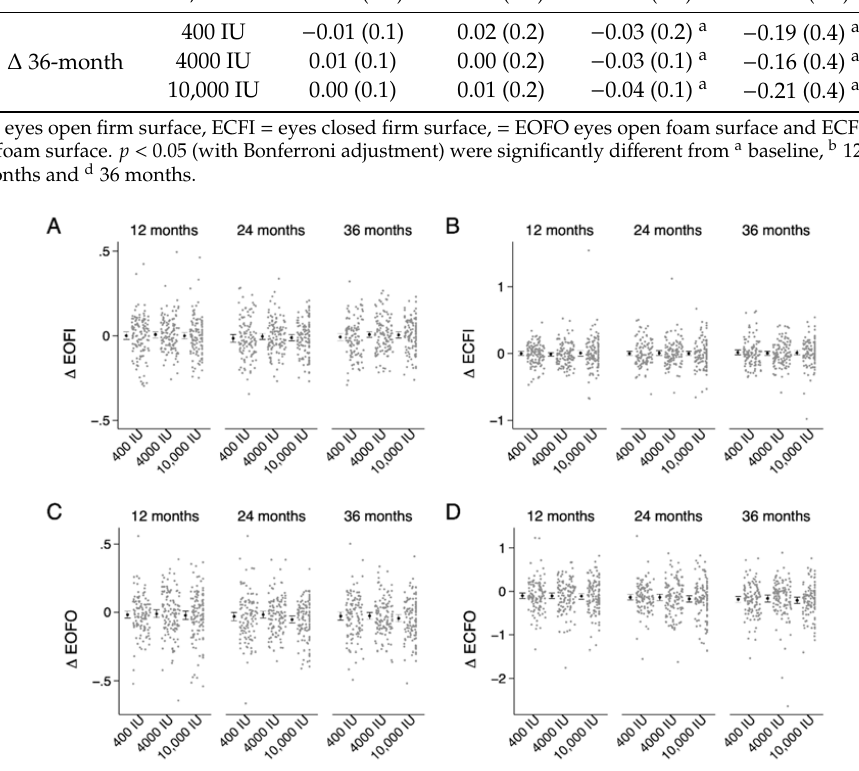
Figure 1. Absolute change in sway index from baseline by treatment group (400 IU, 4000 IU and 10,000 IU) across 36 months of vitamin D supplementation. Individual data points (grey) alongside group means and confidence intervals (black). ( A ) EOFI, eyes open firm surface; ( B ) ECFI, eyes closed firm surface; ( C ) EOFO, eyes open foam surface and ( D ) ECFO, eyes closed foam surface.